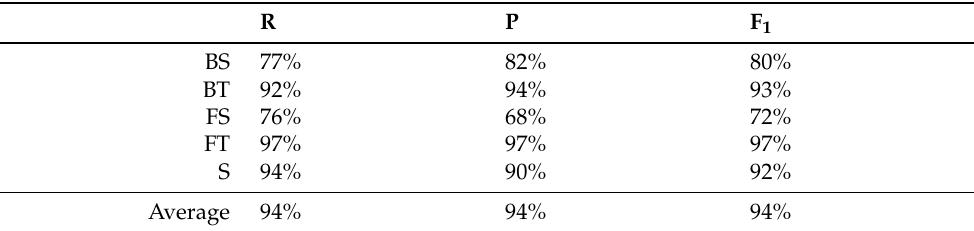
Table 4. Recall, precision, and F 1 score for ResNet for the respective shot types of the best model.